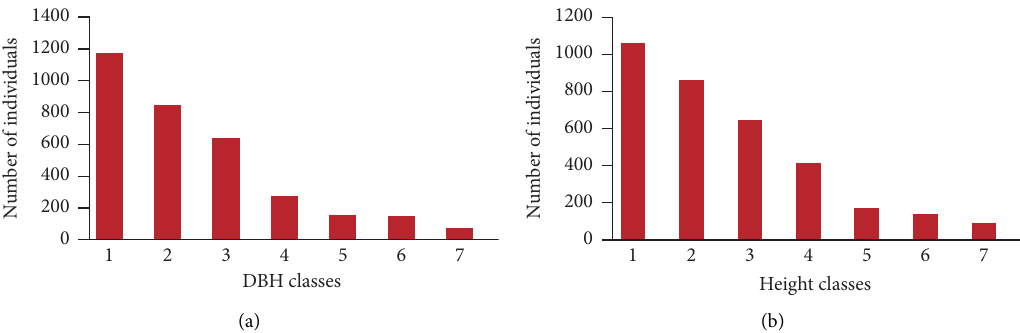
Figure 7: DBH and height class distribution of all individuals. (a) DBH classes: 1 � 5–10cm; 2 � 10.01–20cm; 3 � 20.01–30 cm;